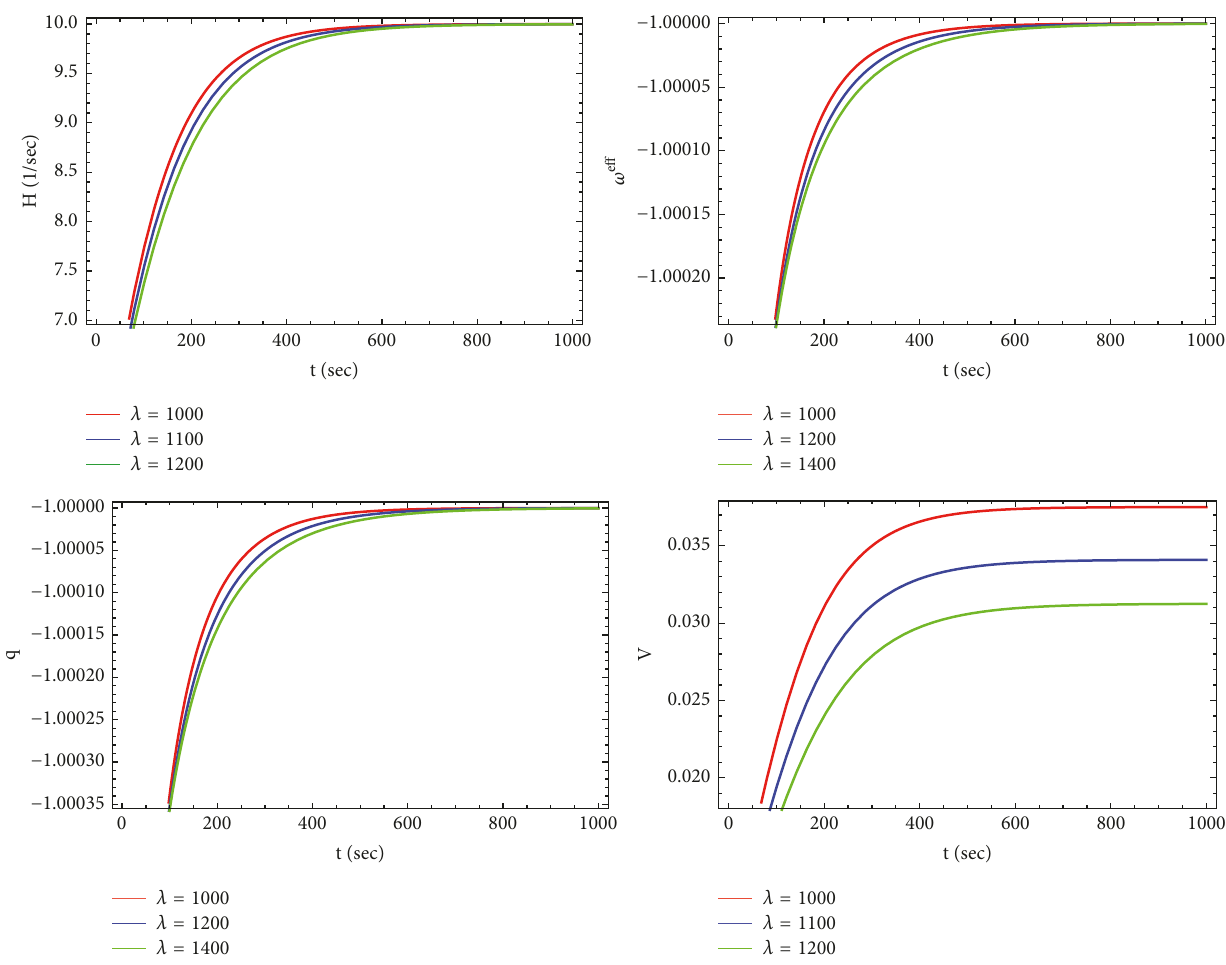
Figure 9: Plots of 𝐻 , 𝜔 𝑒𝑓𝑓 , 𝑞 , and 𝑉 versus 𝑡 for 𝑊(𝜑 − ) = 𝑏 3 sin 𝜑 − , 𝑏 3 = 10(1/𝑠𝑒𝑐) , and 𝜑 − (0) = 0.5 when 𝑘 = −1